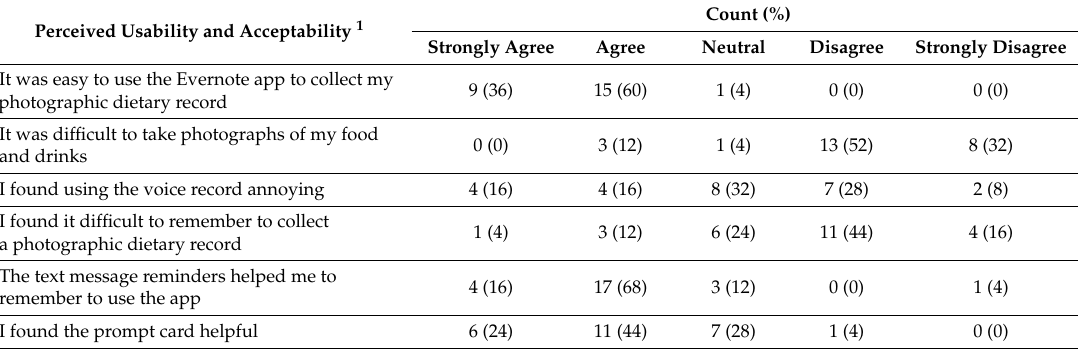
Table 5. Participants’ perceived usability and acceptability of using the Diet Bytes method for dietary assessment ( n =